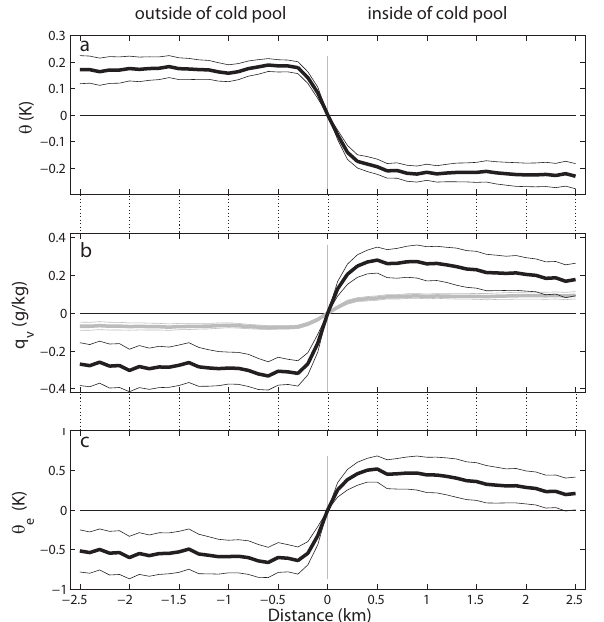
Fig. 12. Composites of dynamic measurements of (a) along-track wind speed ( u ), (b) convergence calculated from u , and (c) vertical wind speed ( w ) across 90 cold-pool edges. Bold lines indicate mean values, while thinner lines indicate the 95% confidence intervals of the mean, calculated using a standard Student t test. For u in (a) , anomalies from the value at the cold-pool edge are composited and plotted, while for convergence and w in ( b and c ) they are not. The 4 /π correction factor is not applied to any of these